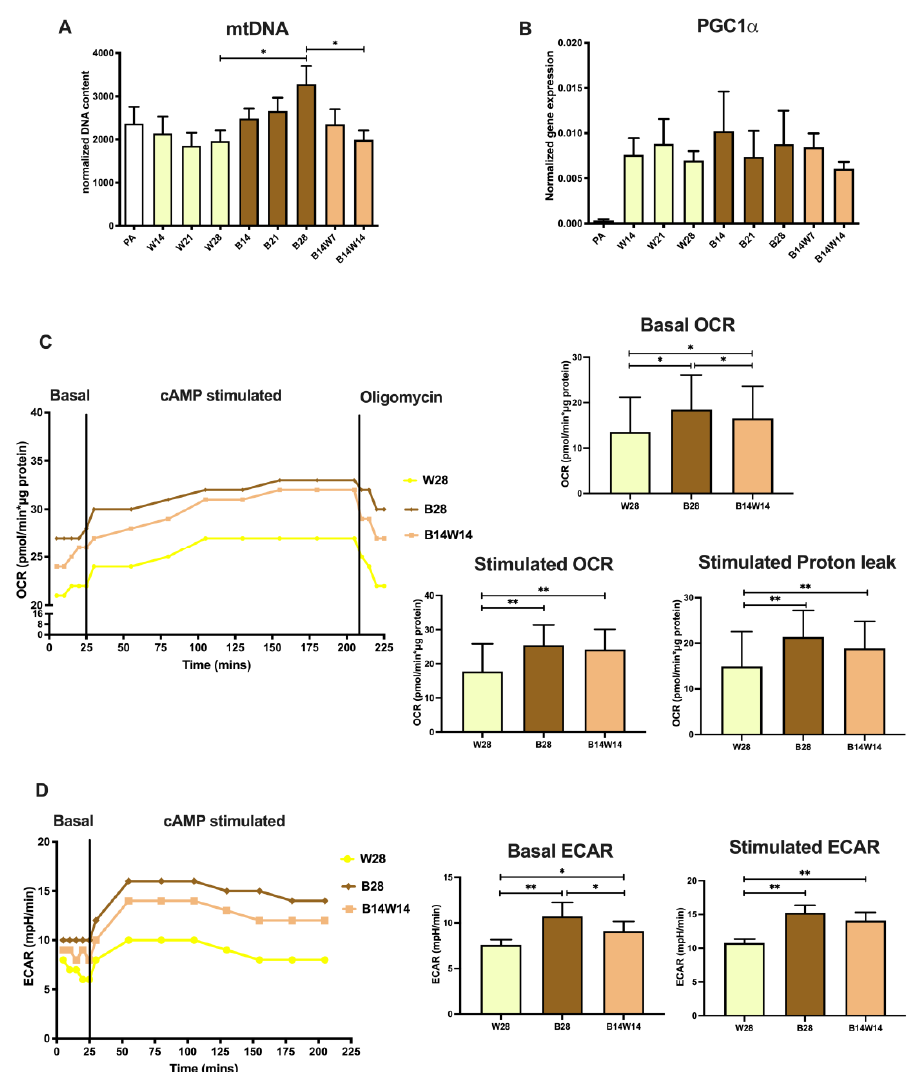
Figure 3. Functional parameters of mitochondrial biogenesis and thermogenesis in white (W) and beige (B) adipocytes, and in response to transition. Human primary abdominal subcutaneous preadipocytes were differentiated as in Figures 1 and 2. Quantification of ( A ) total mitochondrial DNA content ( n = 6) and ( B ) PGC1 α gene expression ( n = 6). ( C ) Representative oxygen consumption rate (OCR) curve, followed by quantification of basal, stimulated, and stimulated proton leak OCR ( n = 4). ( D ) Representative extracellular acidification rate (ECAR) curve, followed by quantification of basal and stimulated ECAR ( n = 4). Gene expression was normalized to GAPDH . Data are presented as mean ± SD. * p < 0.05, ** p < 0.01. We used one-way ANOVA with Tukey’s post hoc